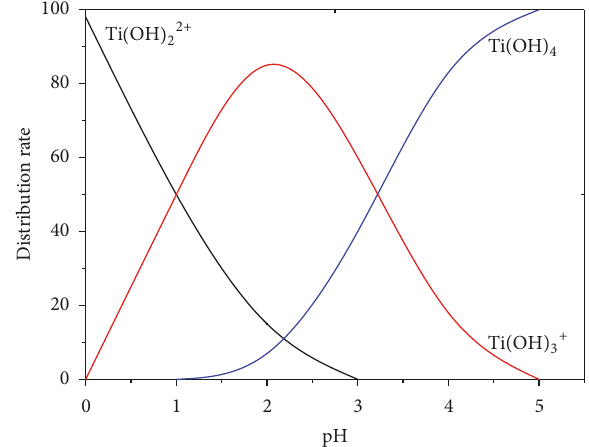
Figure 7: Distribution of Ti 4+ hydrolysis component with pH value.